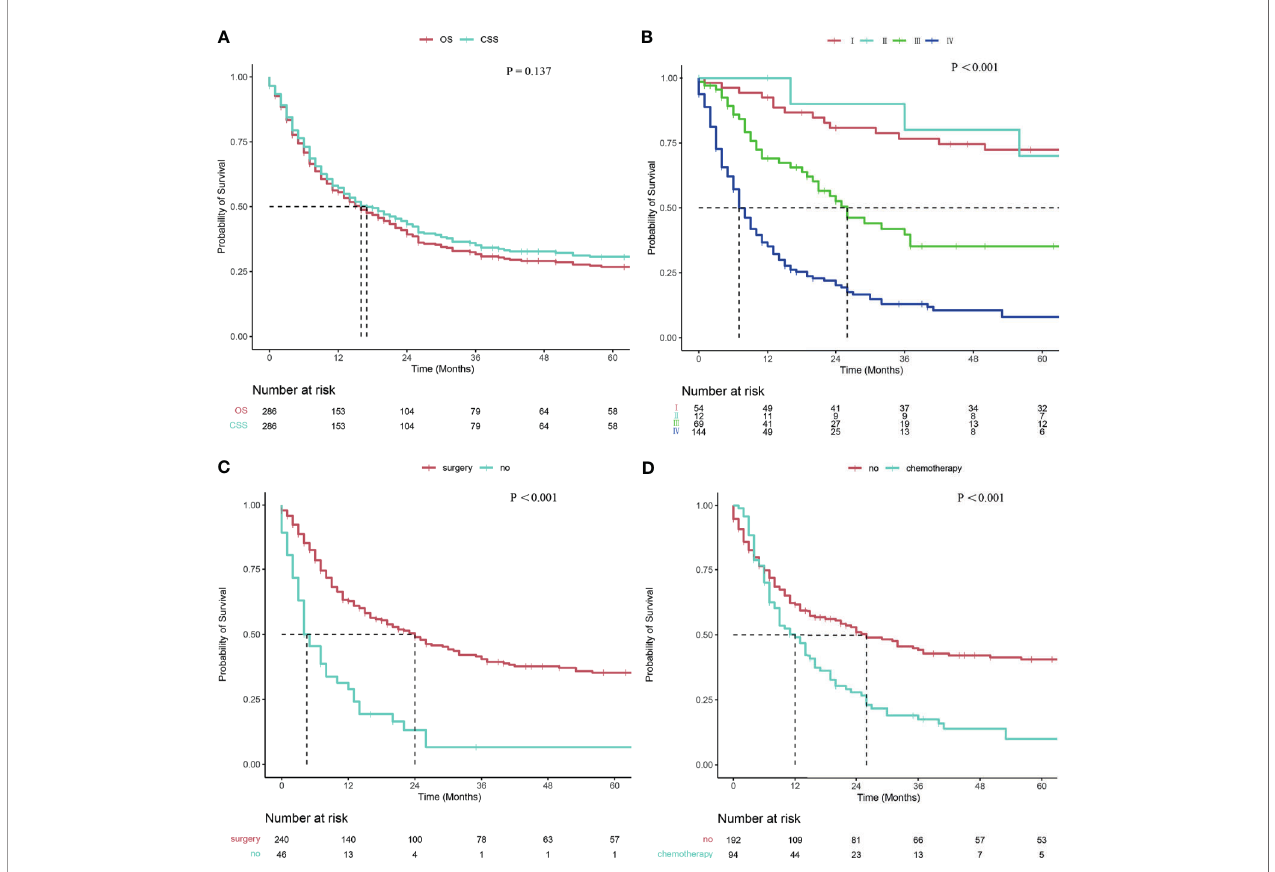
FIGURE 2 | Survival curve of patients with CDCK evaluated using the Kaplan – Meier method. (A) OS and CSS; (B) According to the stage; (C) According to surgery; (D) According to